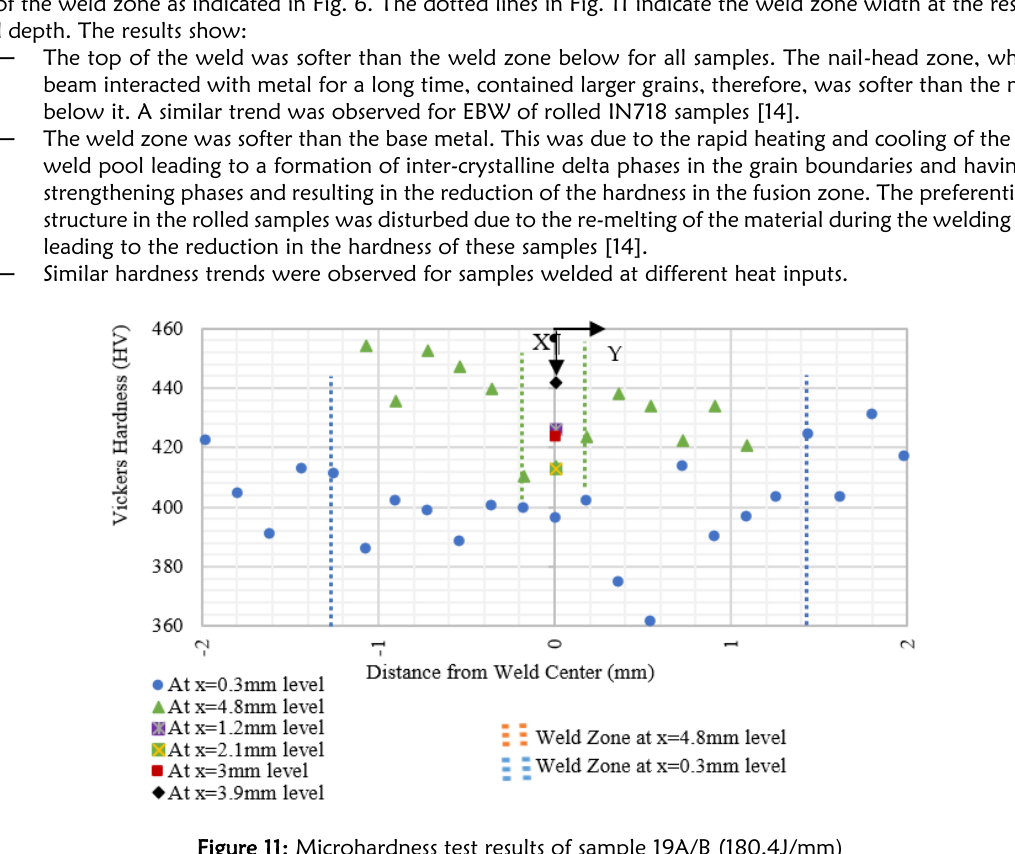
Figure 11: Microhardness test results of sample 19A/B